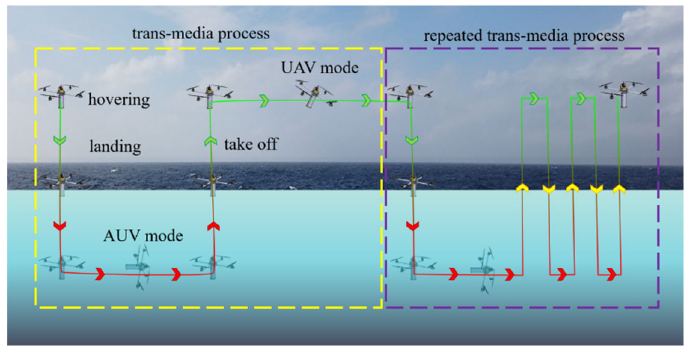
Figure 1. Sketch of the moving process of an HAUV.